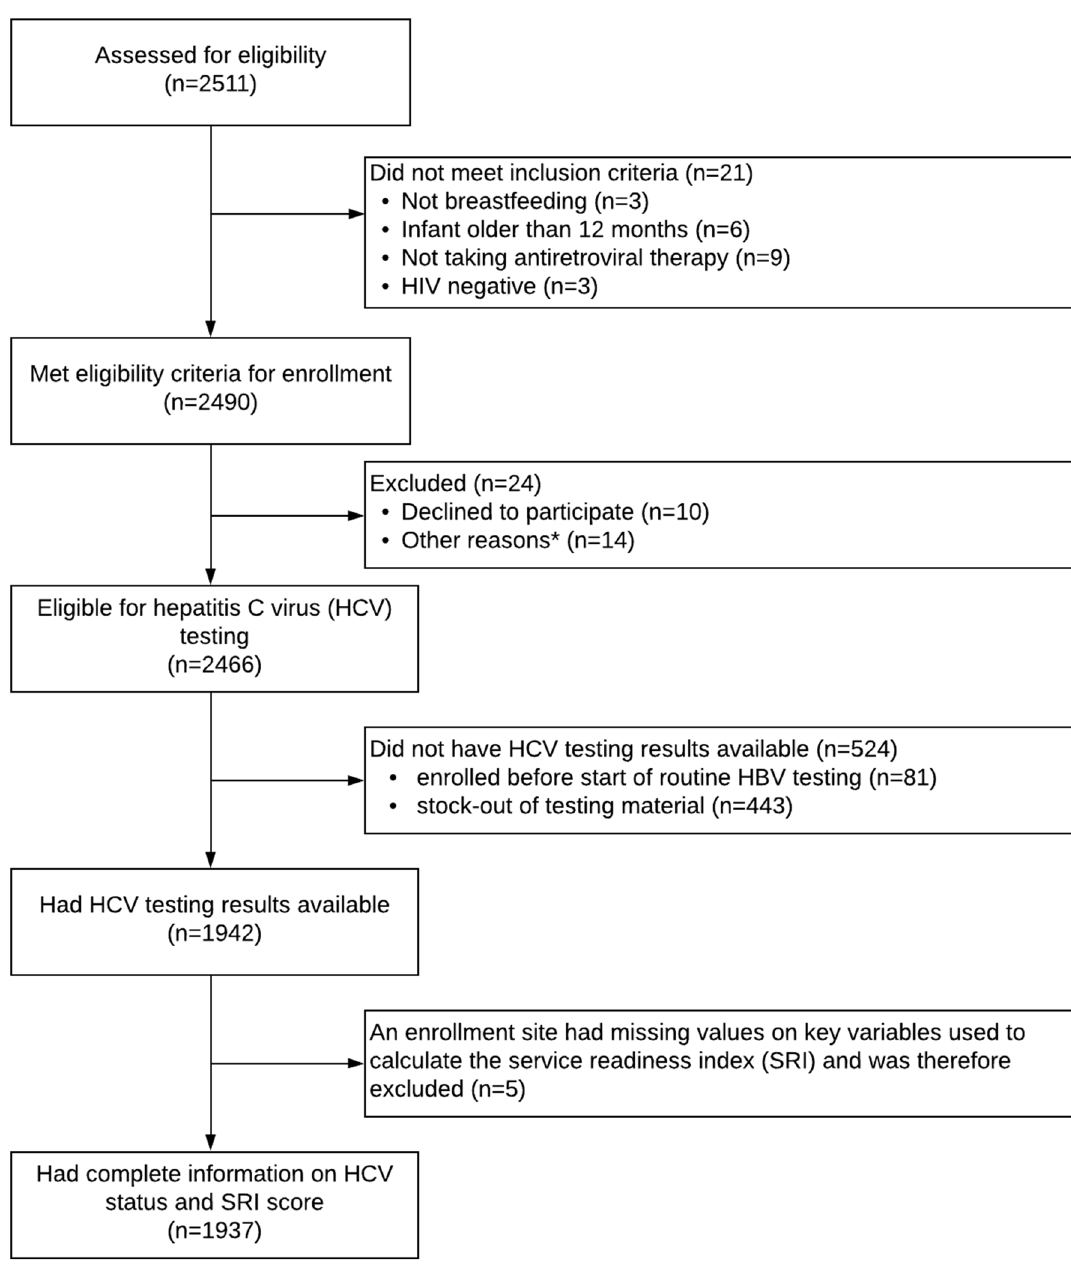
Figure 1. Flow chart of eligibility and